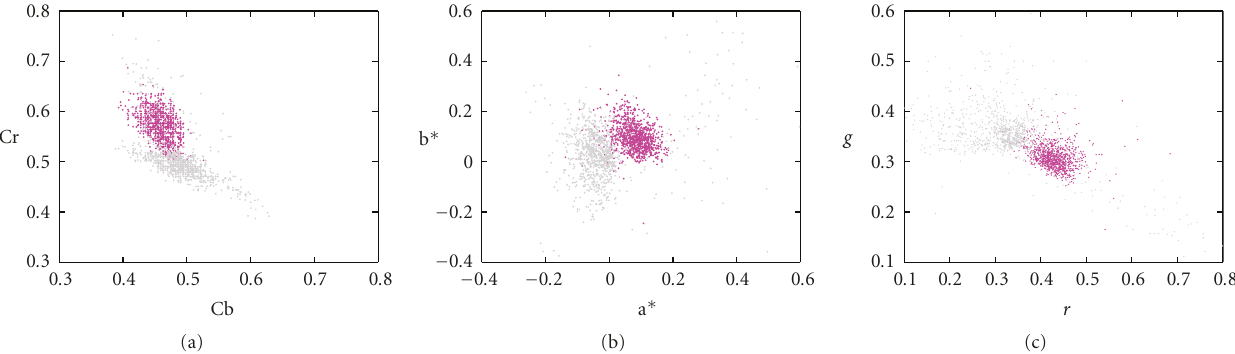
Figure 3: CdB skin (red) and nonskin (gray) samples used for test: (a) in CbCr space; (b) in a ∗ b ∗ components CIEL ∗ a ∗ b ∗ space; (c) in rg component from normalized RGB.